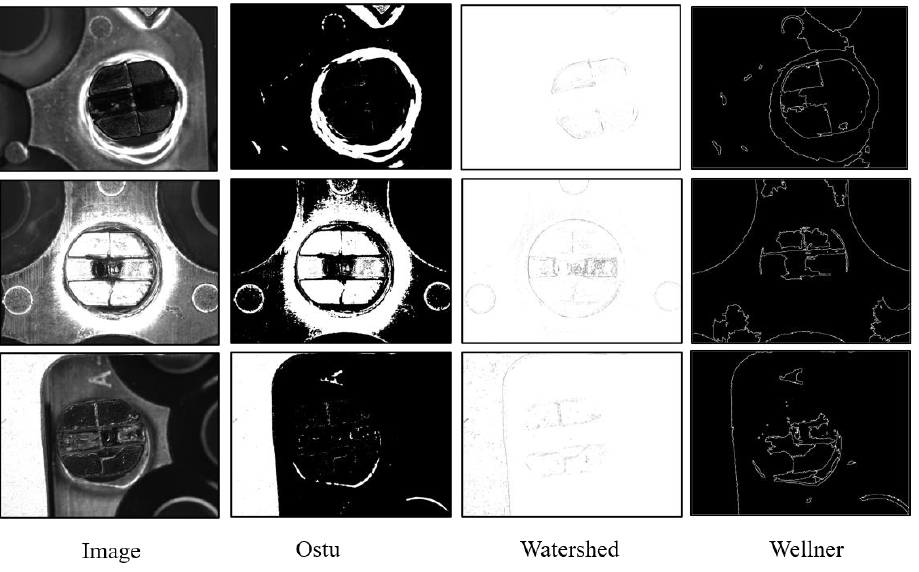
Figure 2. Experimental results of traditional lens buckle segmentation.